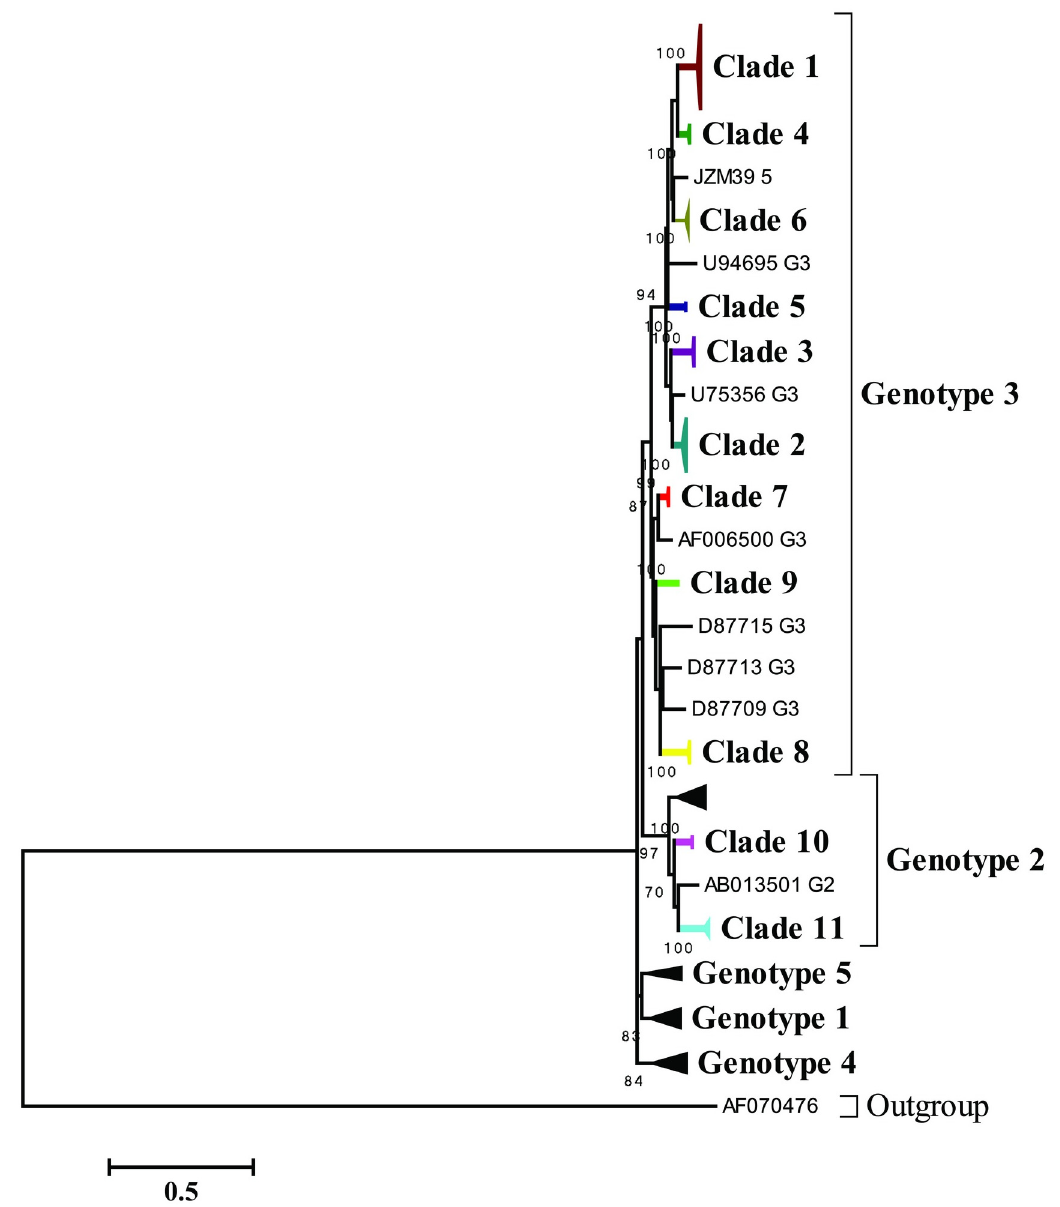
Fig 2. Maximum likelihood tree depicting two and nine clades belong to genotype 2 and genotype 3, respectively. Nodes with bootstrap values > 70 are mentioned at the base of the nodes. Recombinant sequences were excluded from the analyses. Clades that were recovered in the present study are shown in different colors. GenBank reference sequences representing genotypes 1 to 5 are included in the